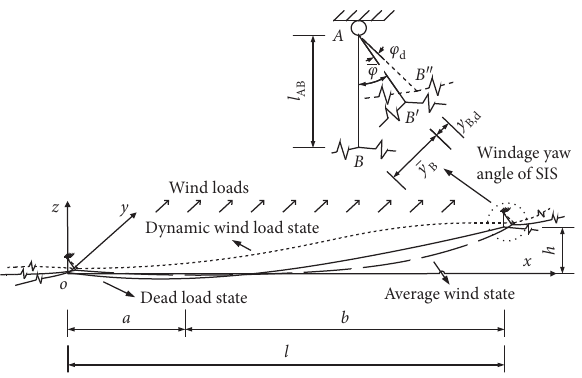
Figure 1: Calculation model of the windage yaw